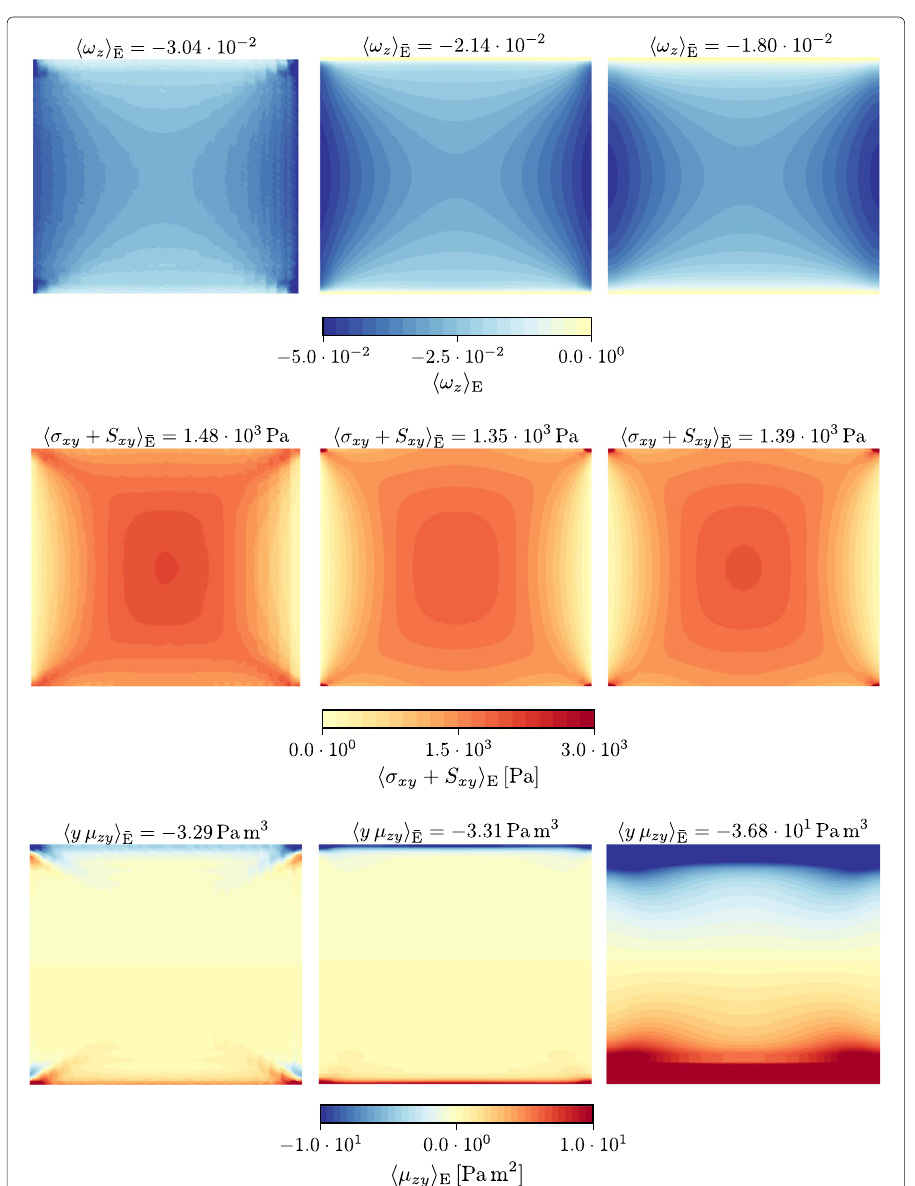
Fig. 5 Comparison of rotation, stress and couple stress fields under simple shear; left: data for regular beam system ( β = 0) averaged over 300 randomly cut-out boundary configurations; center: Cosserat continuum of the same size with material parameters as given in Fig. 4; right: Cosserat continuum with literature parameter ξ = (cid:2) p but same E , ν , G c and dimensions as the Cosserat simulations in the center